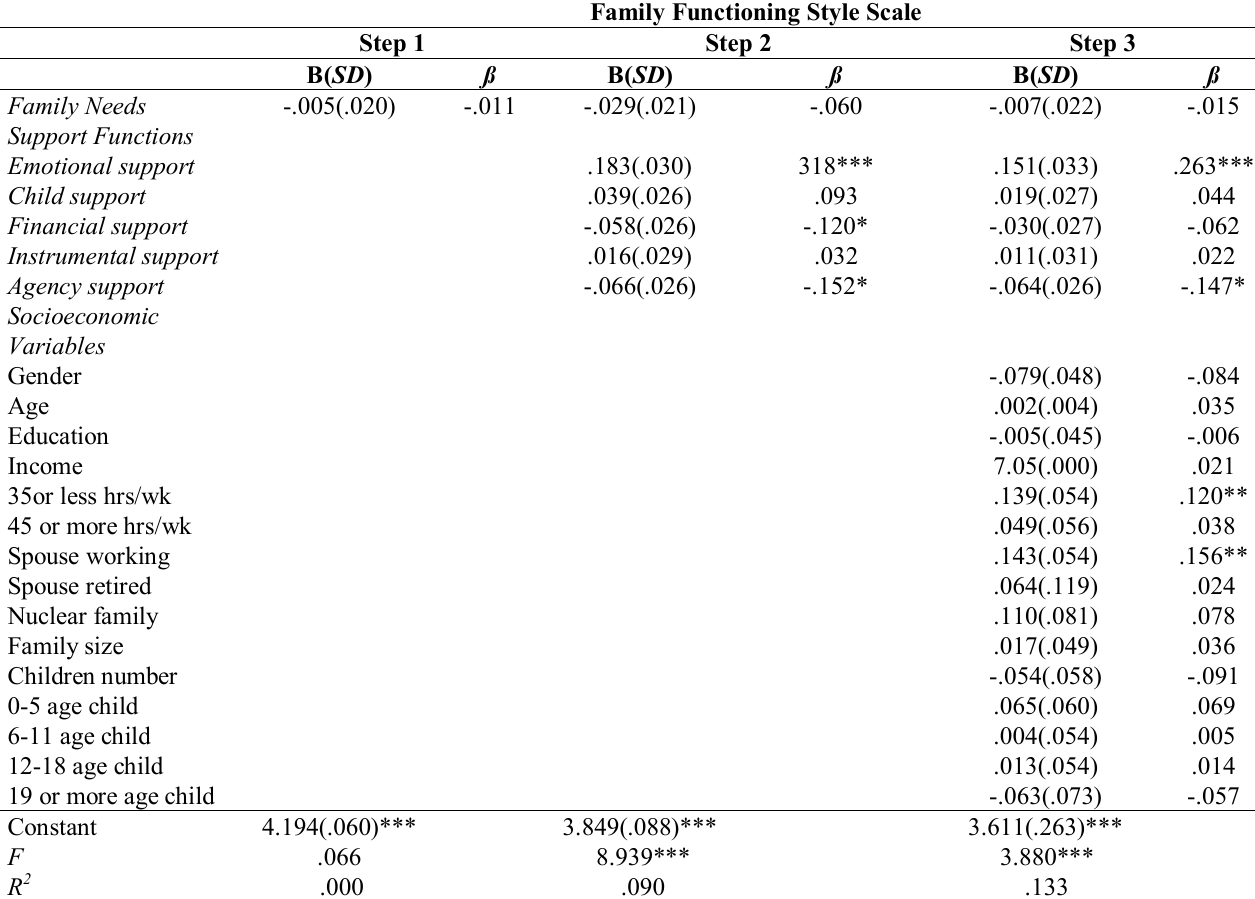
Table 4. OLS Regression Result for Family Functioning Style